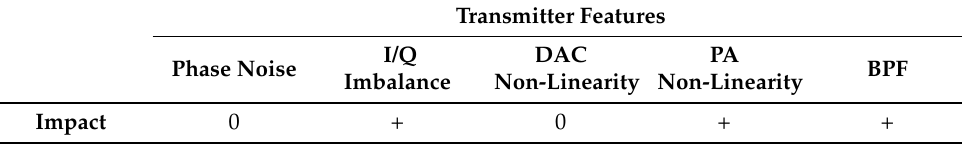
Table 4. Preliminary analysis on the impact of various hardware features upon the capacity to distinguish between transmitters, based on Section 7: 0 = no impact, + = positive impact (i.e., can increase the RFF